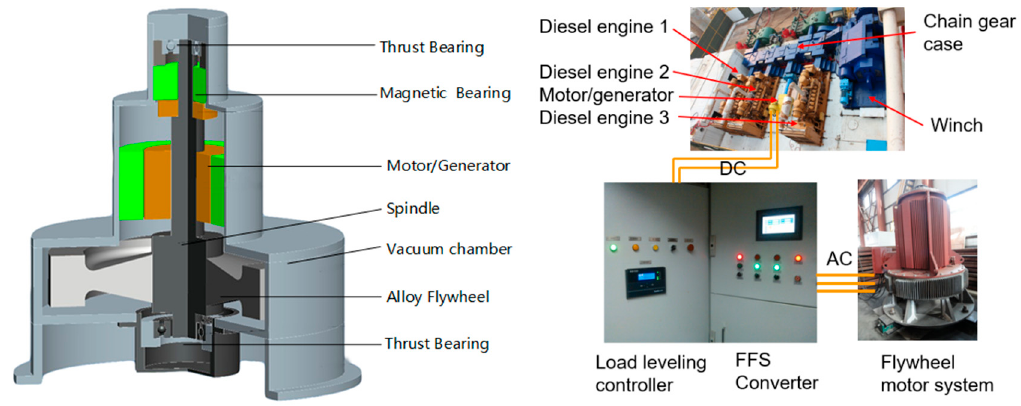
Figure 13. Flywheel configuration and power system of drilling with a peak load leveling system.